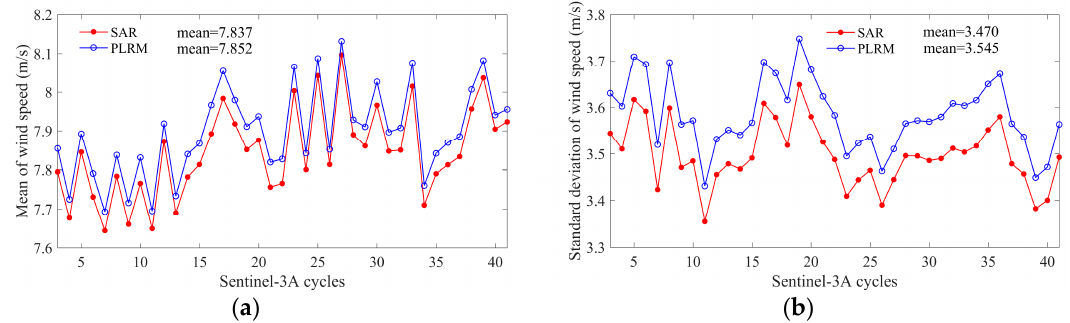
Figure 14. Cycle by cycle ( a ) means and ( b ) standard deviations of wind speeds according to Sentinel-3A repeat cycles.